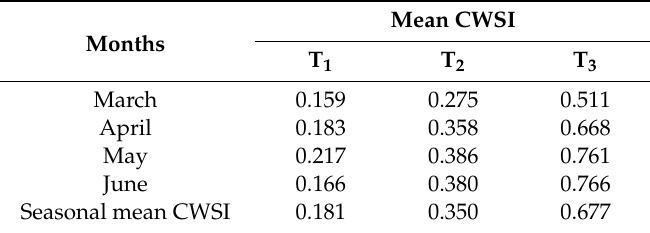
Figure 6. Time evolution of the CWSI during the growing season. T 1 represents 100% M, T 2 represents 80% M, T 3 represents 60%. Table 6. Montly and seasonal mean CWSI values for the treatments.